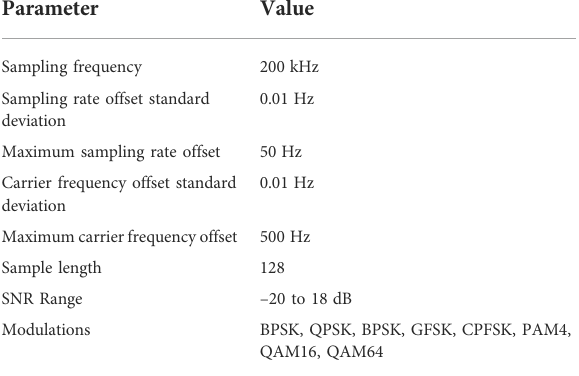
TABLE 2 Description of RadioML 2016.10A